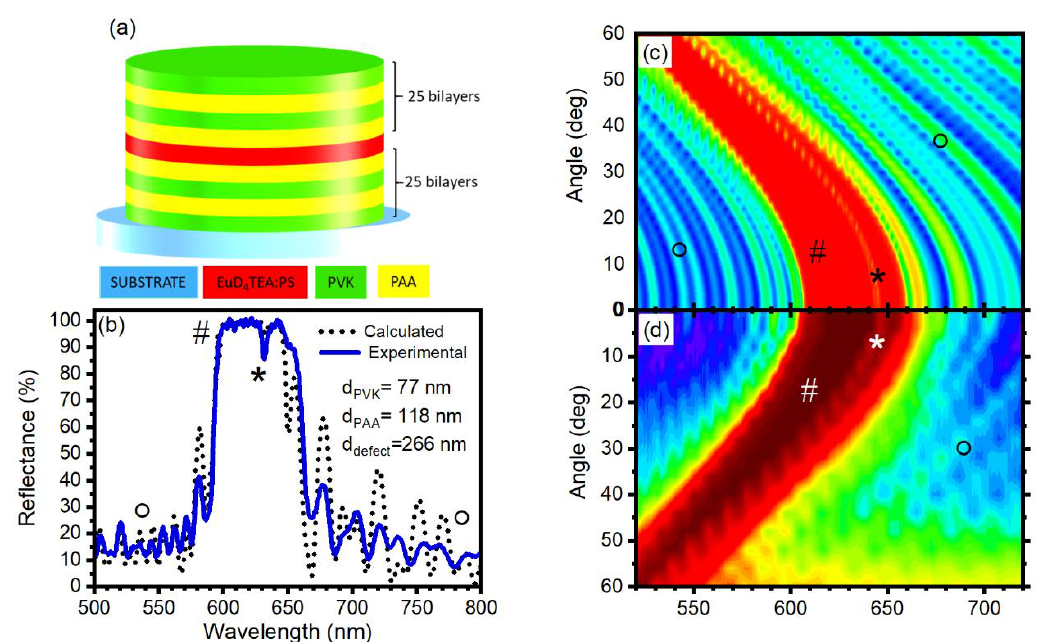
Figure 2. Schematic ( a ) and reflectance spectrum ( b ) of a europium tetrakis (dibenzoyl methide) triethylammonium polystyrene (EuD 4 TEA:PS) microcavity made of poly (N-vinylcarbazole) (PVK) and polyacrylic acid (PAA) as dielectric media. Calculated ( c ) and experimental ( d ) angular resolved transmittance spectra of the microcavity.